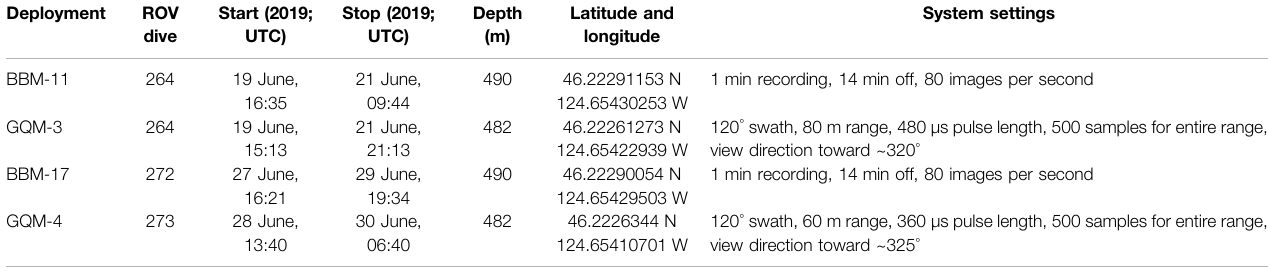
TABLE 1 | Deployment details of the BBox and GasQuant measurements at the AC500 site. Deployment